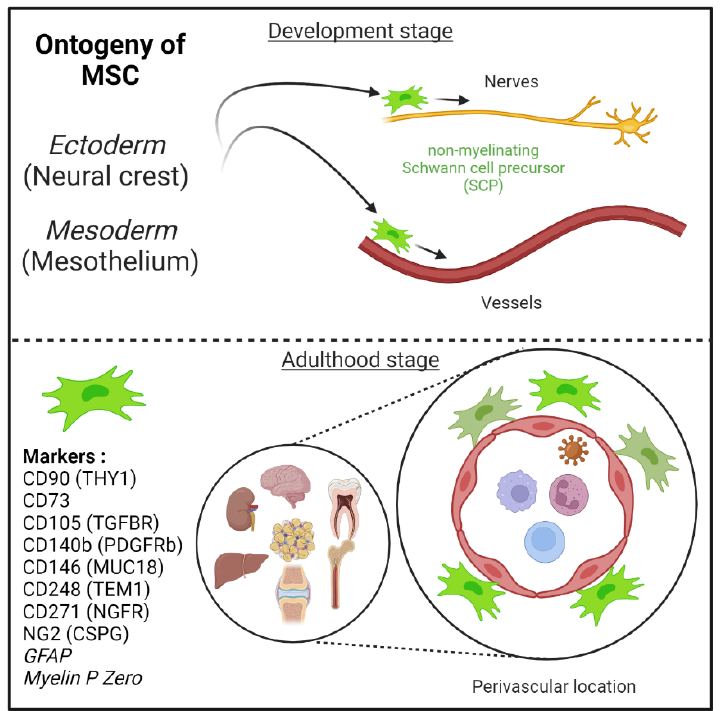
Figure 1. Mesenchymal stem cells (MSC) are derived from either he embryonic ectoderm (neural crest) or the mesoderm. MSCs can migrate along nerves and vessels during development and reside in virtually all post-natal organs and tissues. Along the nerves, MSCs are also known as non-myelinating precursor Schwann cells. Their location around vessels to form perivascular immune privileged niches has been demonstrated by several teams. MSC express several canonical markers which are differentially expressed in all major organs. CD271, GFAP, and MPZ are canonical neuroglial markers.